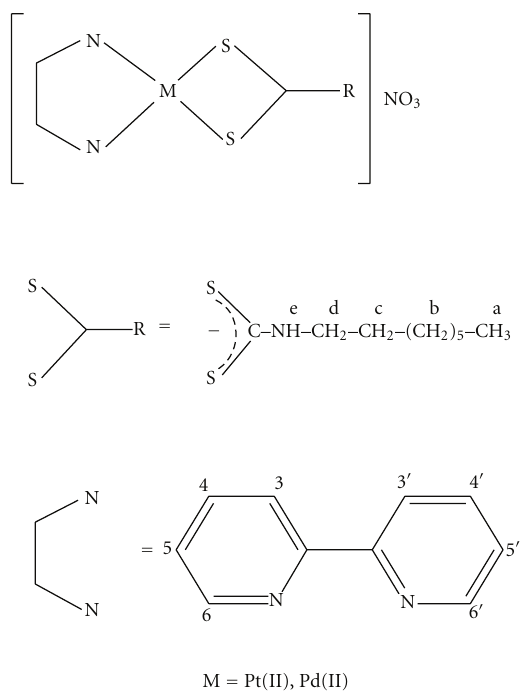
Scheme 1: Proposed structures and proton NMR numbering schemes of [Pt/Pd(bpy)(Oct-dtc)]NO 3